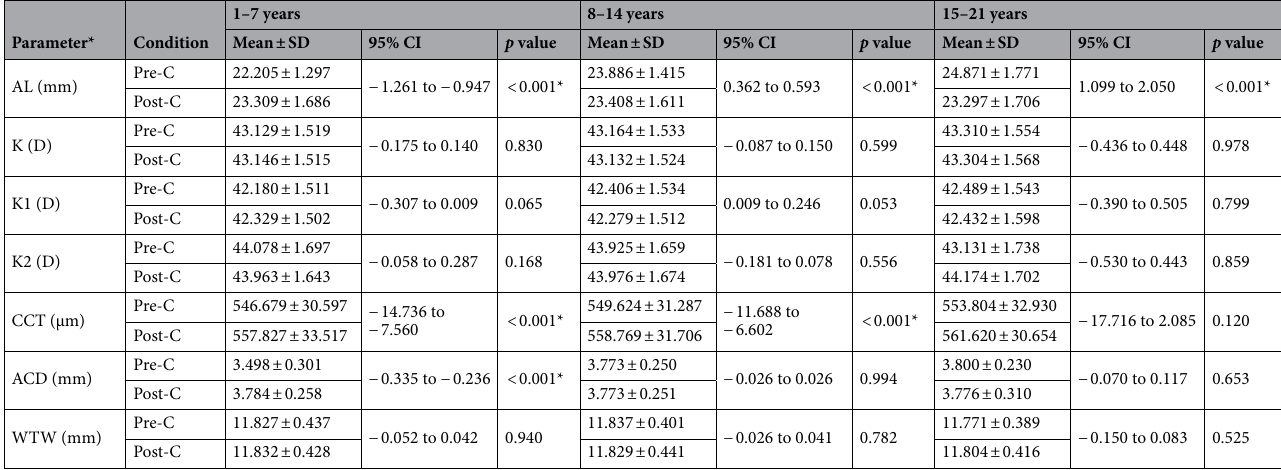
Table 4. Statistical analysis of the mean, SD, and 95% CI of ocular biological characteristics of the subjects pre- and postcycloplegia in group 1 (age ranging from 1 to 7 years), group 2 (age ranging from 8 to 14 years) and group 3 (age ranging from 15 to 21 years). AL axial length; K mean keratometry, K1 flat keratometry, K2 steep keratometry, CCT central corneal thickness; ACD anterior chamber depth; WTW white-to-white distance; D dioptre; C cycloplegia; SD standard deviation, CI confidence interval. * p < 0.05 was considered statistically significant.